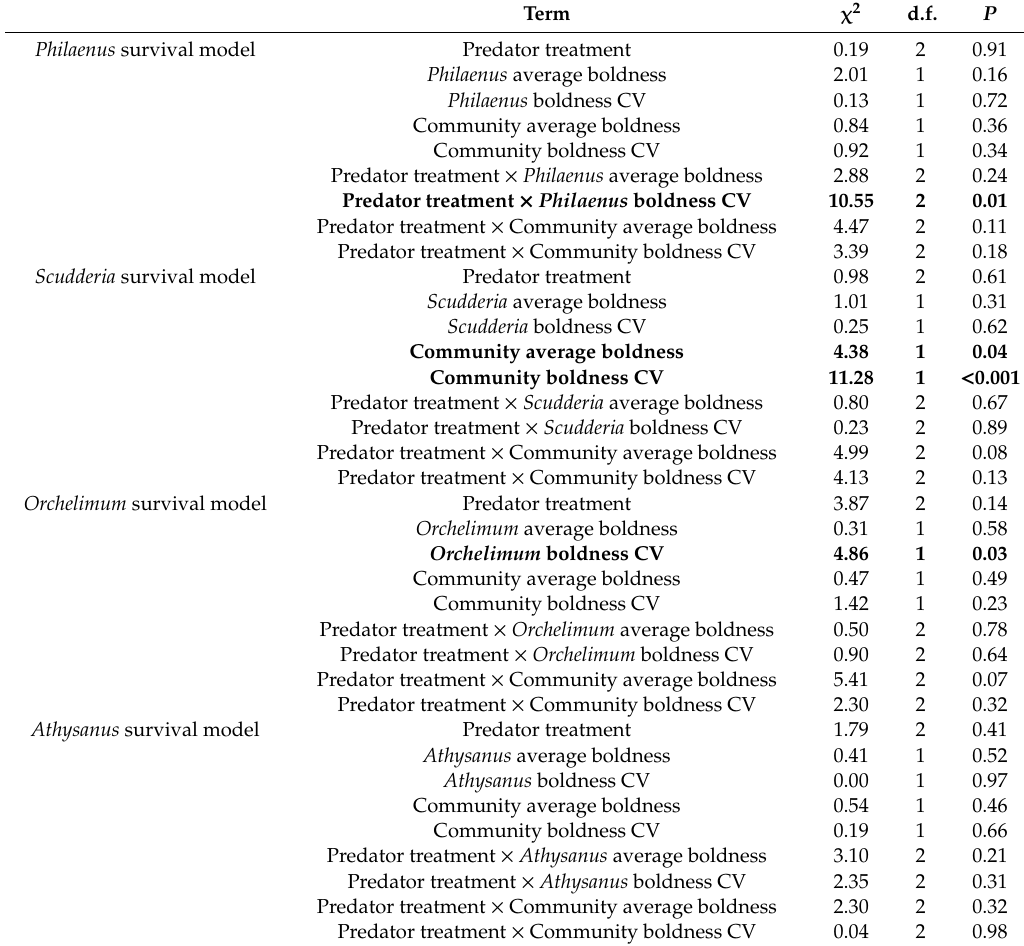
Table 1. ANOVA tables for insect prey survival generalized linear models. Significance of fixed e ff ects, tested using likelihood-ratio Chi-square tests, indicated in